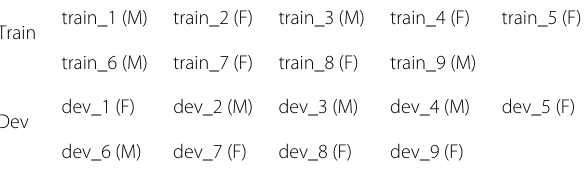
Table 1 RECOLA database sub-partition naming and speaker gender in